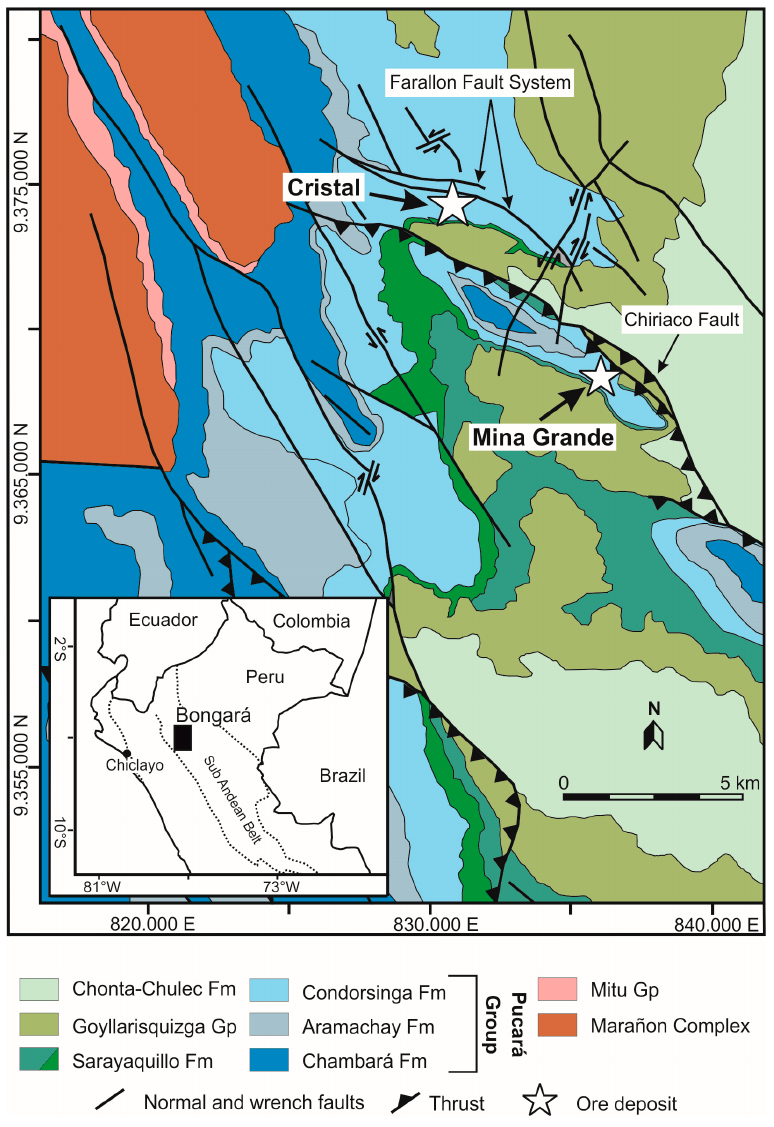
Figure 1. Location of the Bongará province within the Sub Andean Belt and geological map of the Mina Grande and Cristal areas modified from [34 ] .